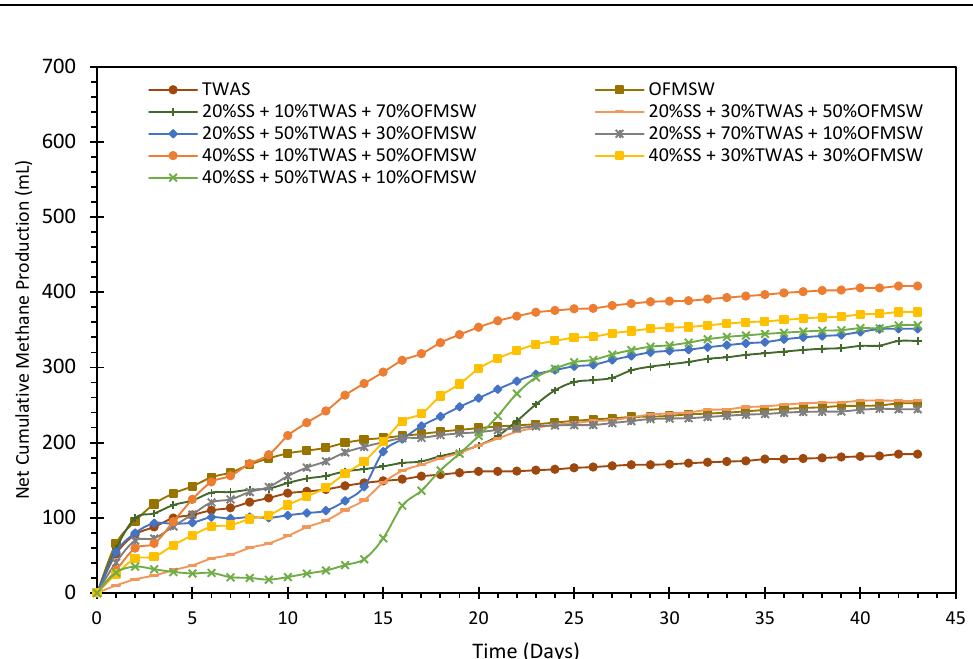
Figure 2. Comparison of the cumulative methane yield from TWAS and OFMSW with trinary co ‐ digestion mixtures.